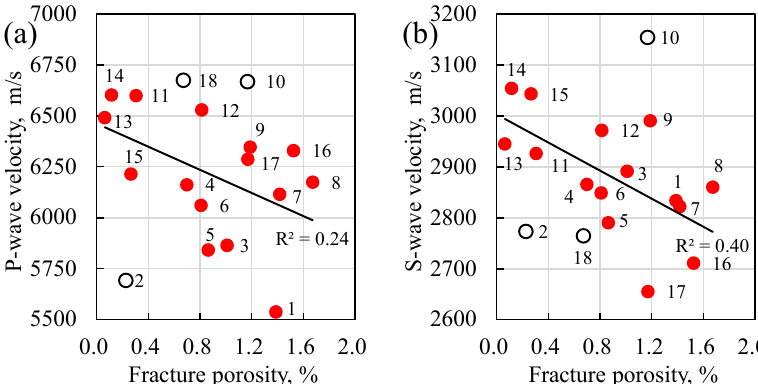
Figure 12. The cross plots of ( a ) P- and ( b ) S-wave porosity against fracture porosity. For the convenience in referring the dots to the micro-CT images, the number of the samples are marked on the figure. The red solid and black empty dots represent the data collected from the samples possessing fractures with low and high orientation angles, respectively. Decreasing trends of the wave speeds with porosity are observed for both P- and S-waves in the samples mainly containing low orientation fractures.